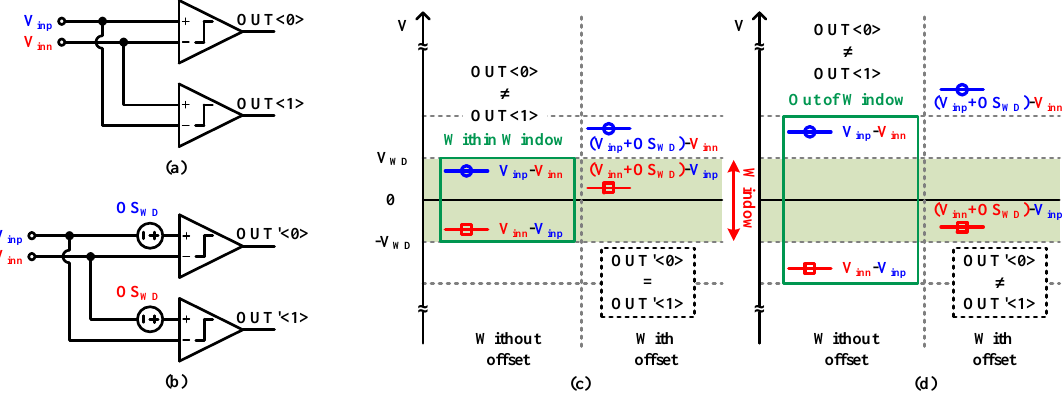
Figure 10. The input cross-coupled comparators ( a ) without and ( b ) with offset, and the comparator outputs equality ( c ) inside, and ( d ) outside window.